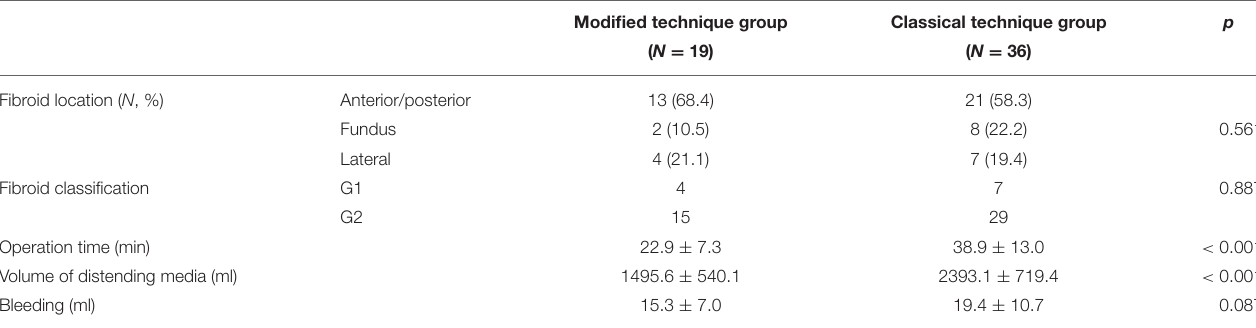
TABLE 2 | Perioperative data of patients in the two groups.